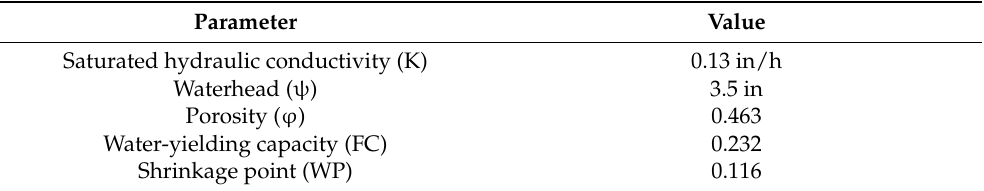
Table 1. List of Soil-related Parameters.